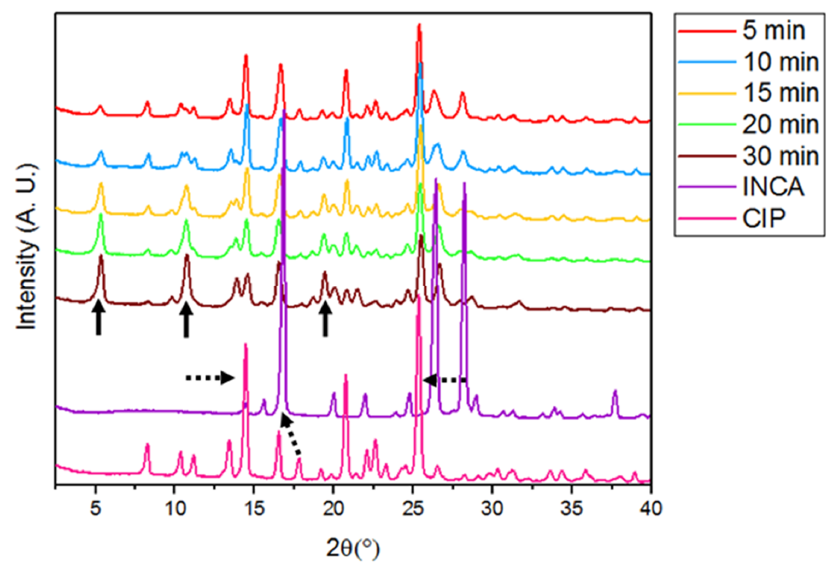
Figure 4. PXRD spectra of ground samples ball milled at 30 Hz for various duration of times.